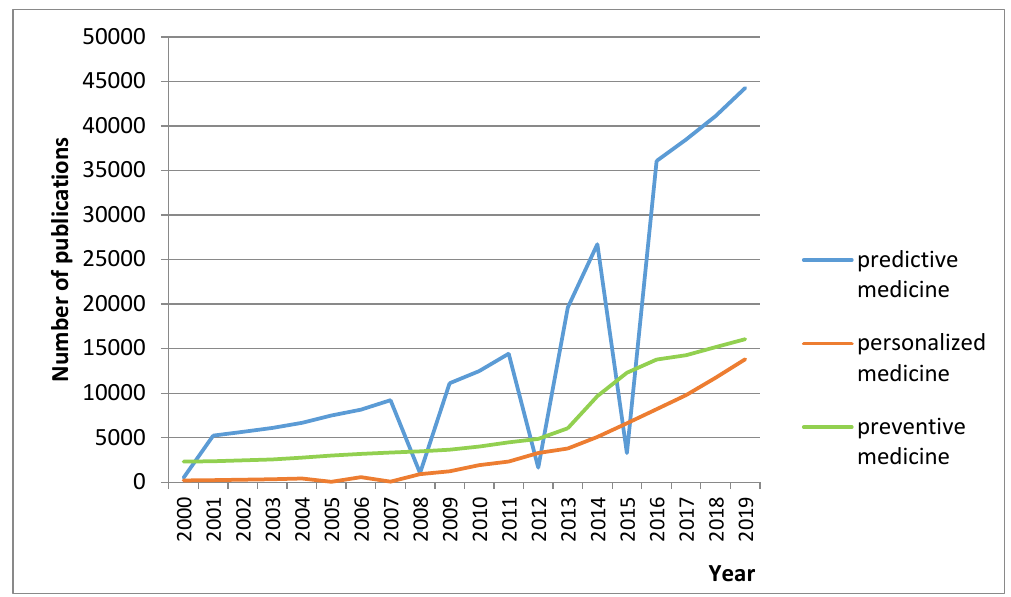
Figure 1. Absolute number of publications in the PubMed database from 2000 to 2019 received by a title / abstract search using the terms “predictive medicine”, “personalized medicine”, and “preventive medicine” [1].